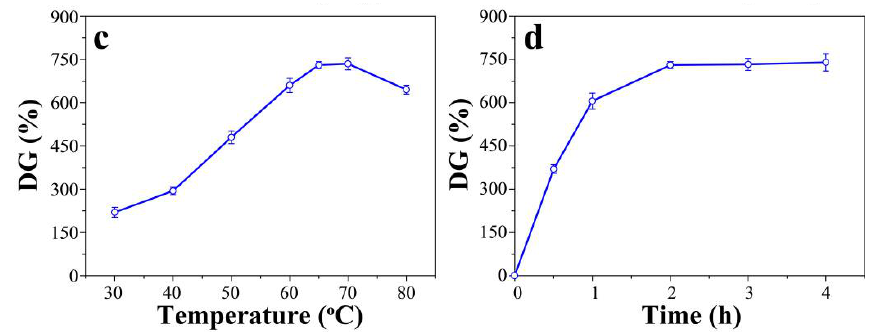
Figure 1. DG of UHMWPE fibers as a function of ( a ) absorbed dose (10 vol%, 65 °C, 2 h), ( b ) GMA concentration (150 kGy, 65 °C, 2 h), ( c ) reaction temperature (150 kGy, 10 vol%, 2 h), and ( d ) reaction time (150 kGy, 10vol%, 65 °C).